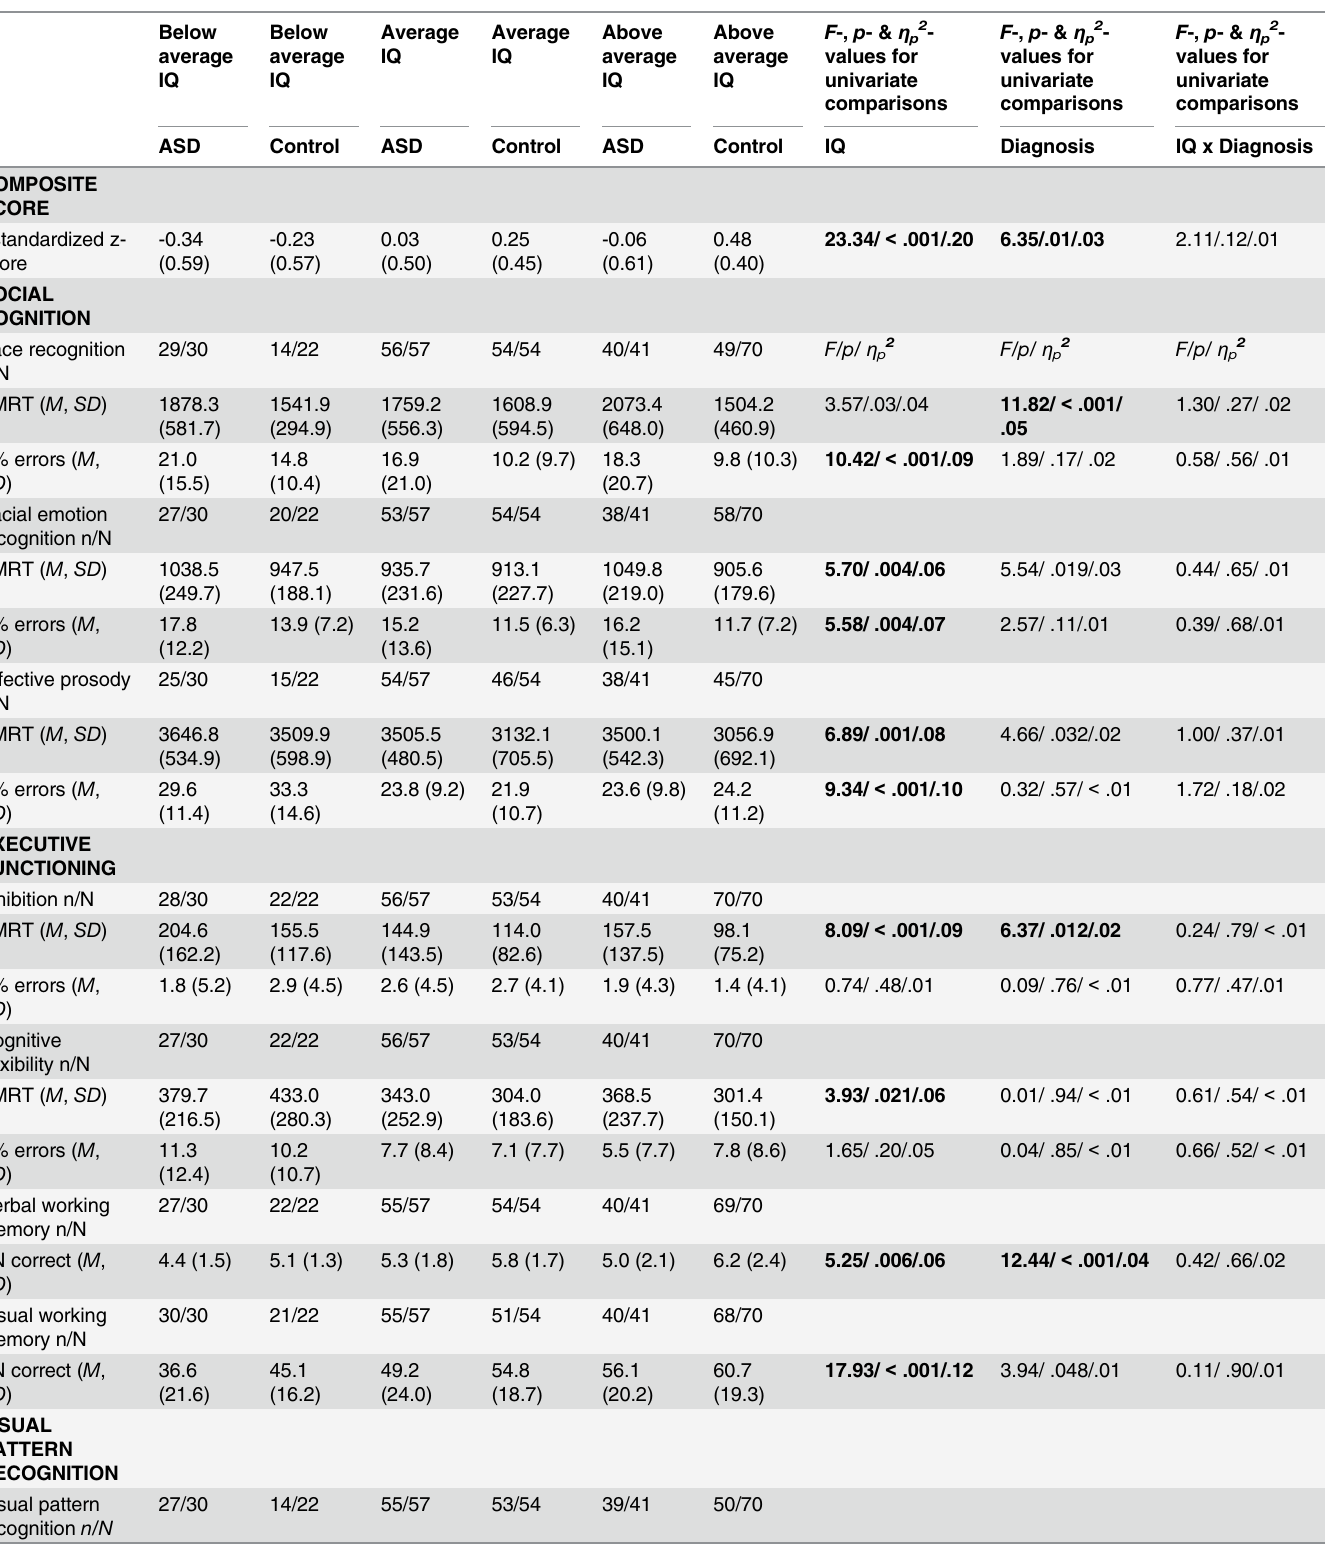
Table 3. Means and standard deviations of the unstandardized cognitive task variables for below average, average and above average intelligent ASD and control children. Below